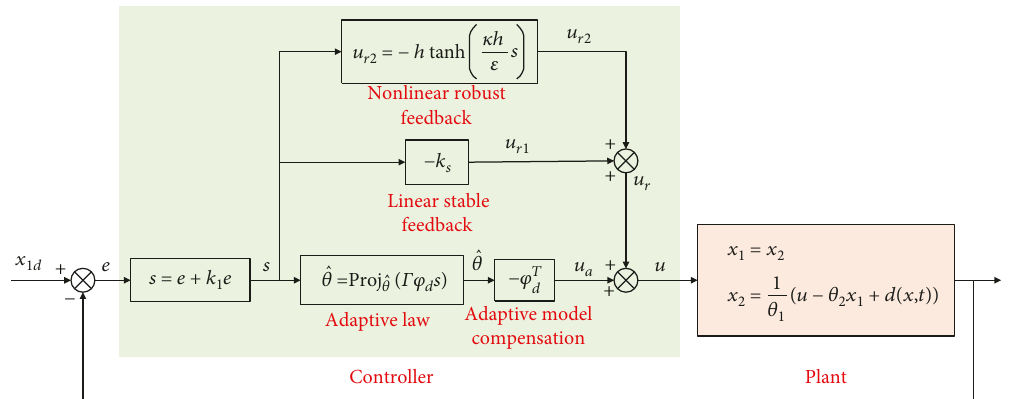
Figure 3: DCARC block diagram.